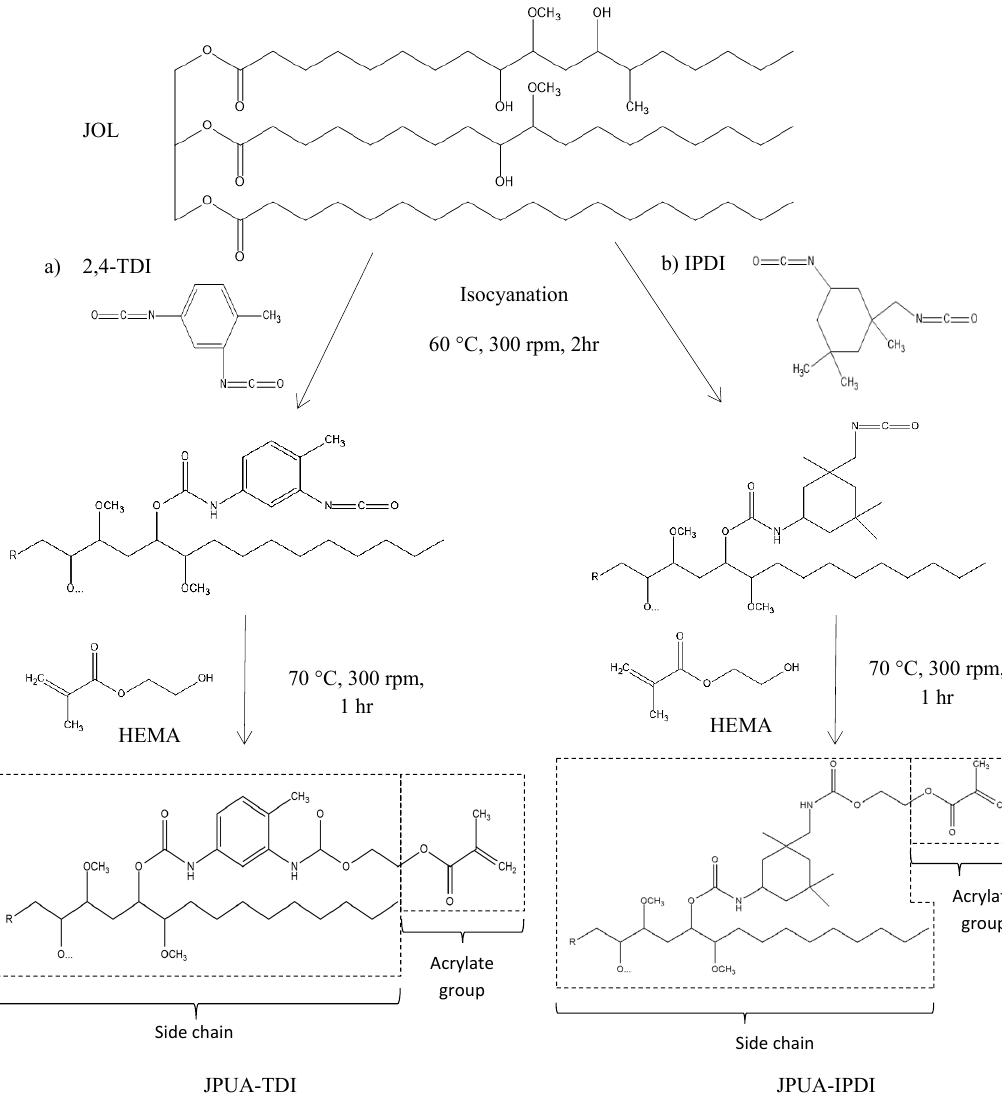
Figure 4. Isocyanation of JOL to produce (a) JPUA-TDI and (b) JPUA-IPDI.